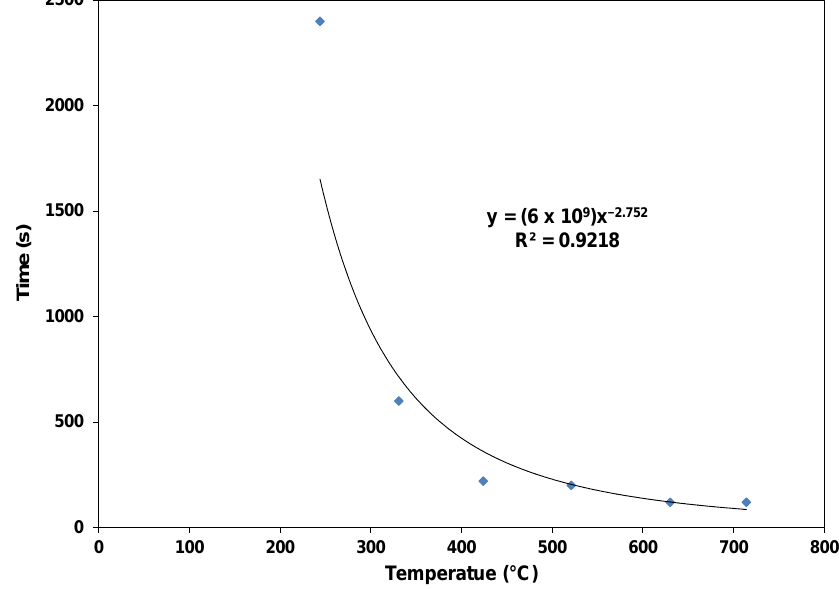
Figure 11. Fixed Carbon profile at different temperatures during the combustion.